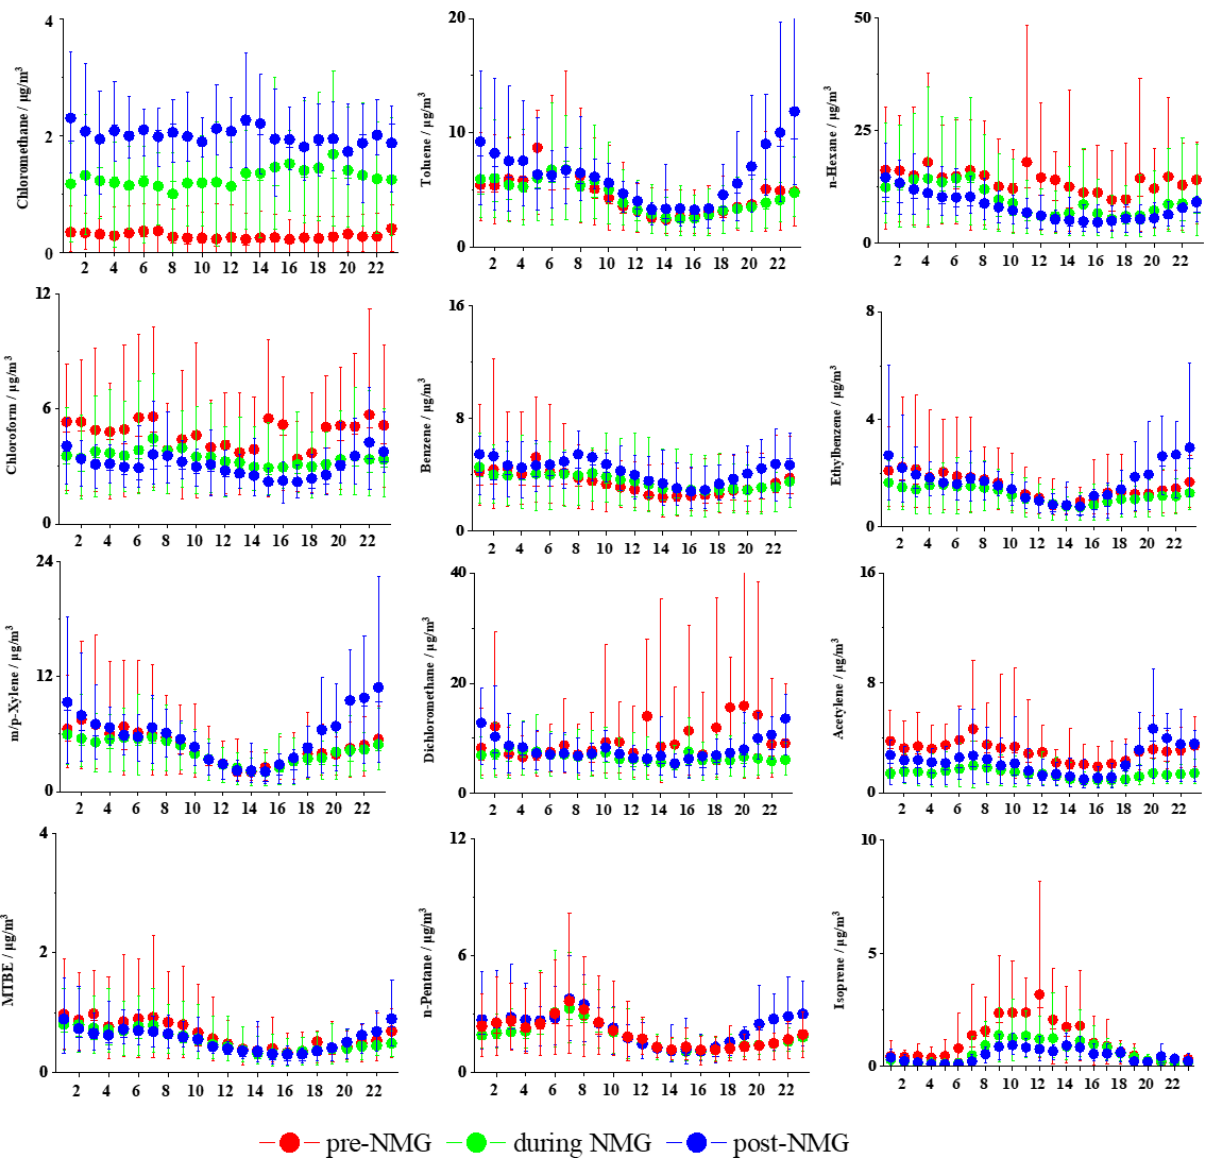
Figure 3. Diurnal variations in concentrations of some reactive VOC species in Zhengzhou during the three